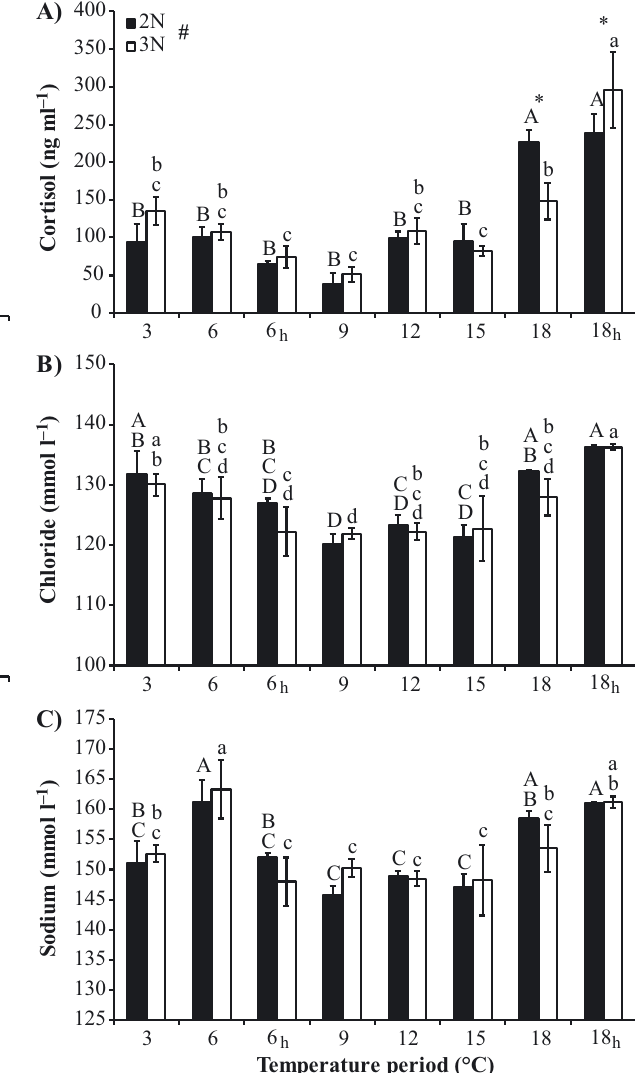
Fig. 6. Mean ± SE plasma (A) cortisol, (B) chloride and (C) sodium levels in large diploid and triploid Atlantic salmon Salmo salar in seawater. See Fig. 2 for explanation of